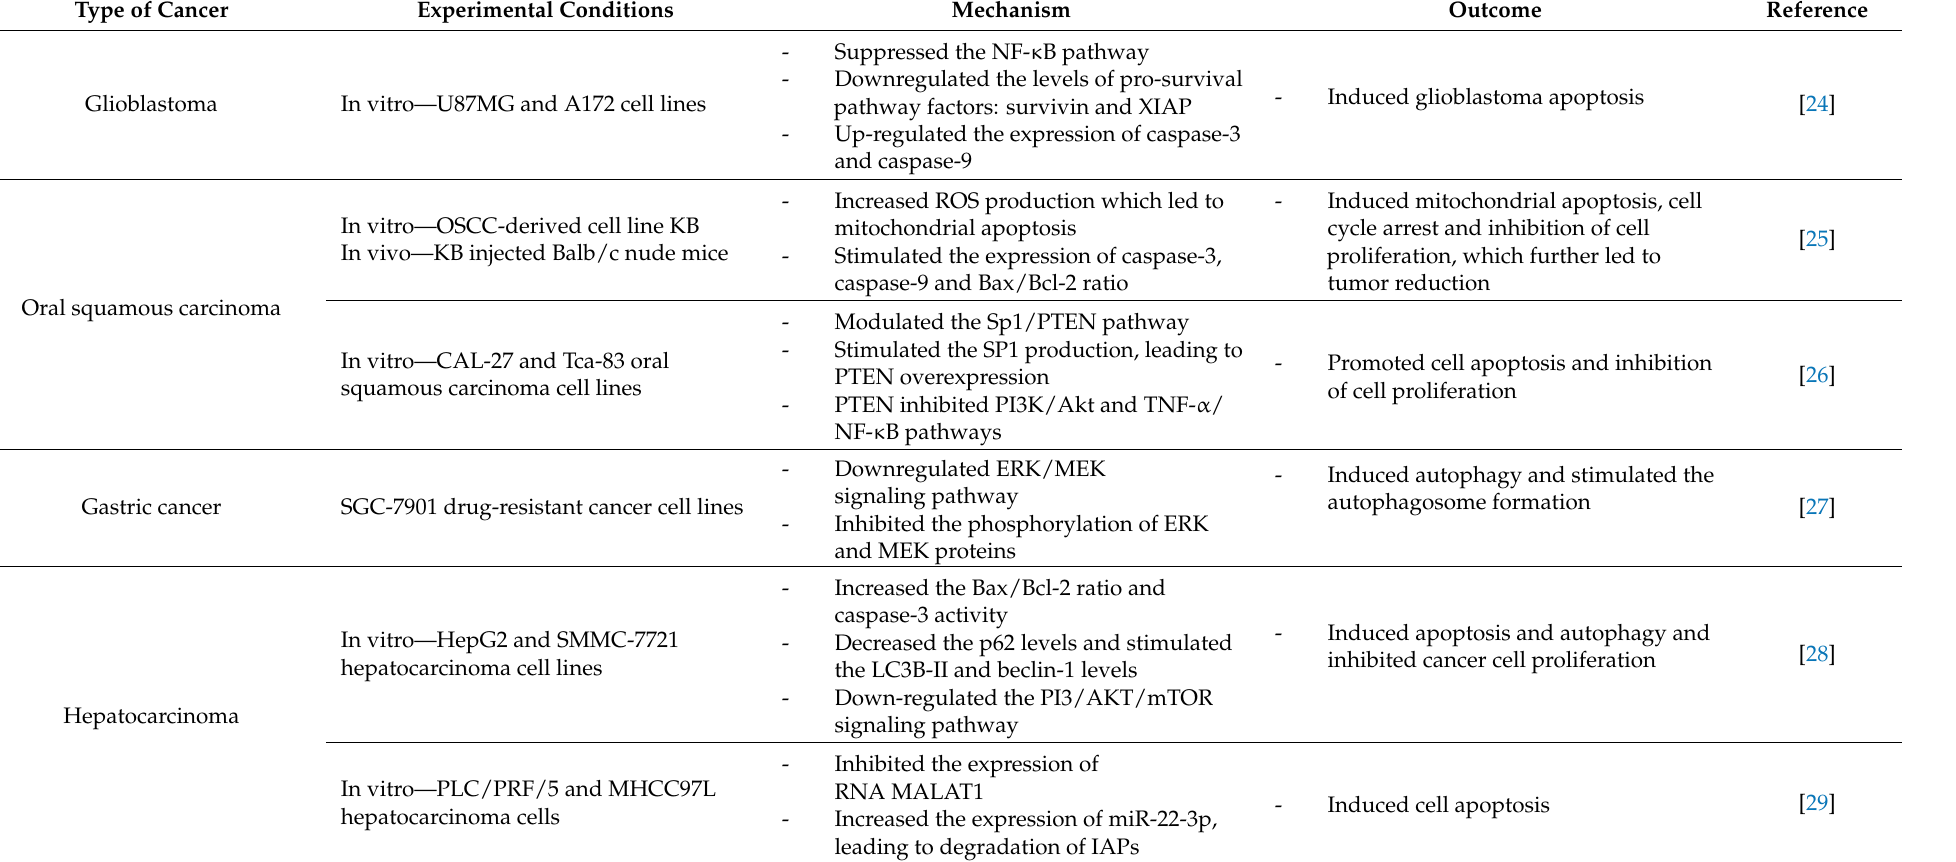
Table 1. In vitro and in vivo biological activity of betulinic acid against different types of